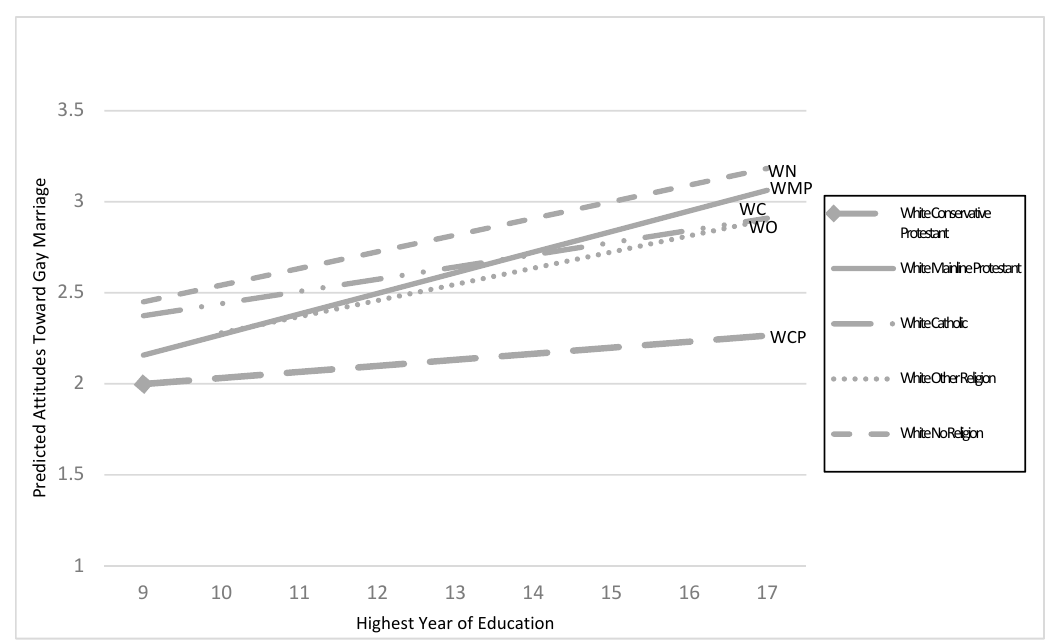
Figure 3. The interaction of religion and education on views on gay marriage.